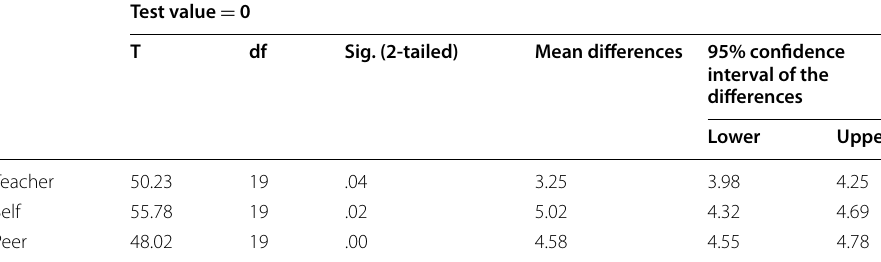
Table 11 One‑sample test of the attitude